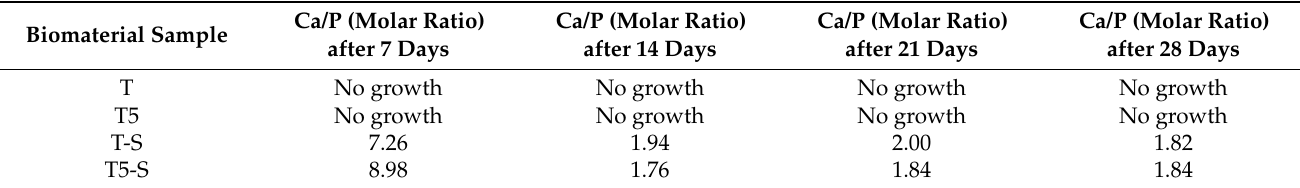
Table 3. Ca/P ratios obtained from EDS measurements for the T, T5, T-S, and T5-S samples after immersion in SBF for 1–4 weeks.